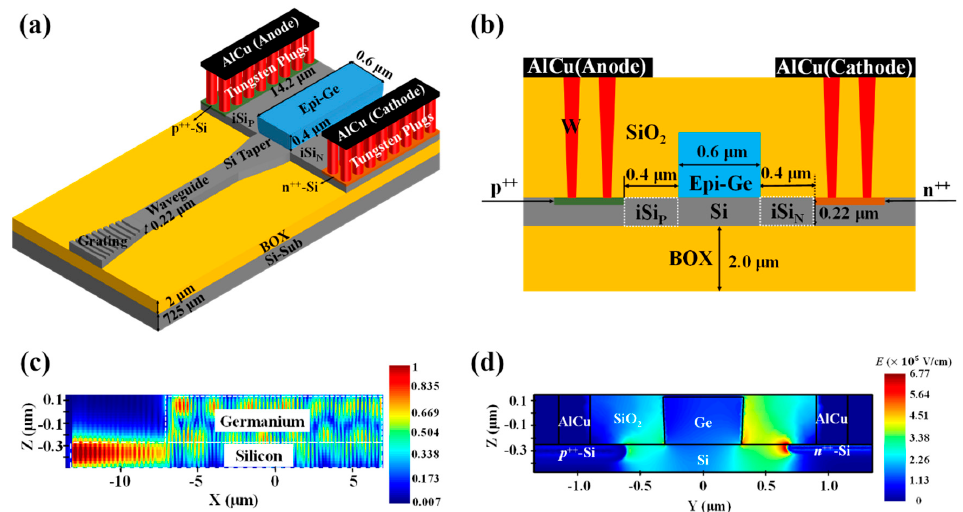
Figure 1. Structure of the waveguide-integrated SAM Ge/Si APD. ( a ) 3D schematic of the device; ( b ) the cross-section of the device; ( c ) the electric component of the optical field inside the device (simulation using Lumerical FDTD); ( d ) the electric field profile inside the device at avalanche breakdown (simulation using Lumerical DEVICE).